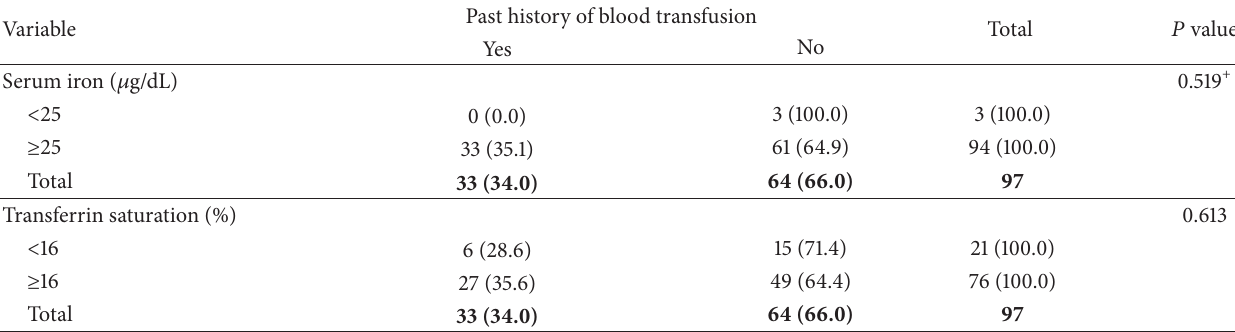
Total Values in parenthesis are % of column total. + Chi-square test ( 𝜒 2